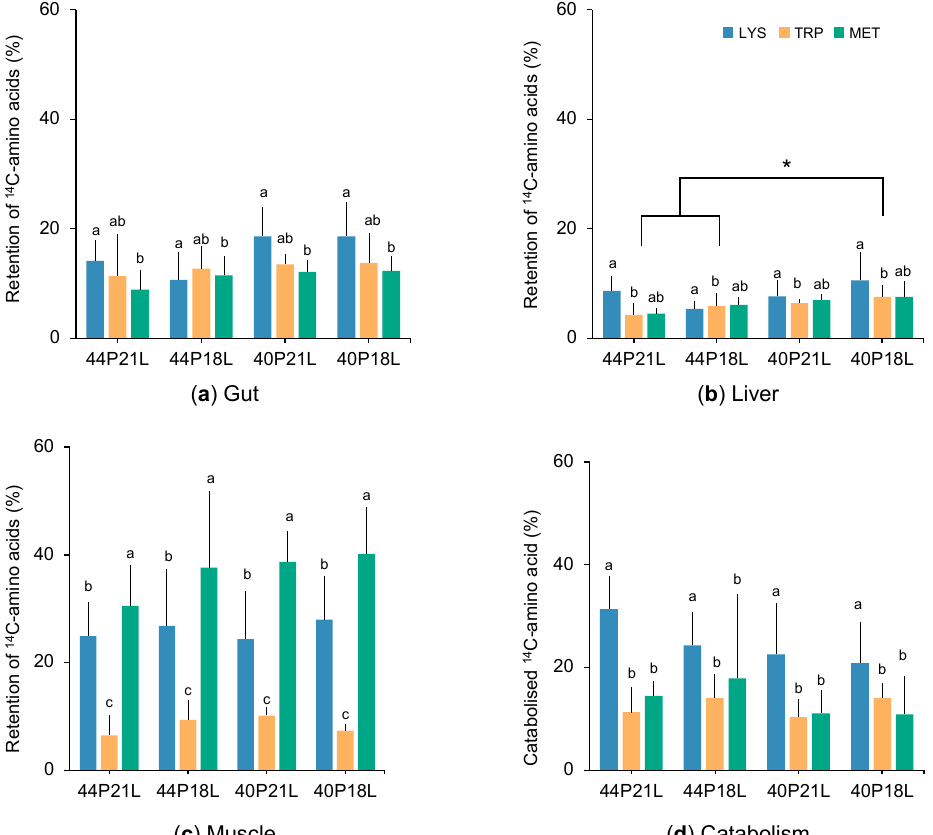
Figure 2. Proportion (%) of the total recovered 14 C-amino acids lysine (LYS), tryptophan (TRP) and methionine (MET) that was retained in the: gut ( a ); liver ( b ); and muscle ( c ); or catabolised ( d ) in gilthead seabream juveniles fed 44P21L, 44P18L, 40P21L or 40P18L diets. Values are presented as mean ± standard deviation ( n = 6 fish for each diet and tracer). Letters (a, b, c) represent significant differences among amino acids metabolic fate as a function of their nature, and * denote significant differences among dietary treatments (two-way ANOVA followed by Tukey’s multiple-comparison test, p < 0.05).